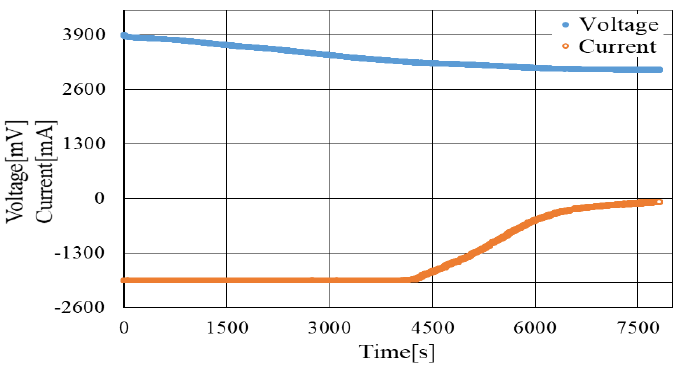
Figure 7. Discharging characteristic of Li-Ion during CCCV mode.